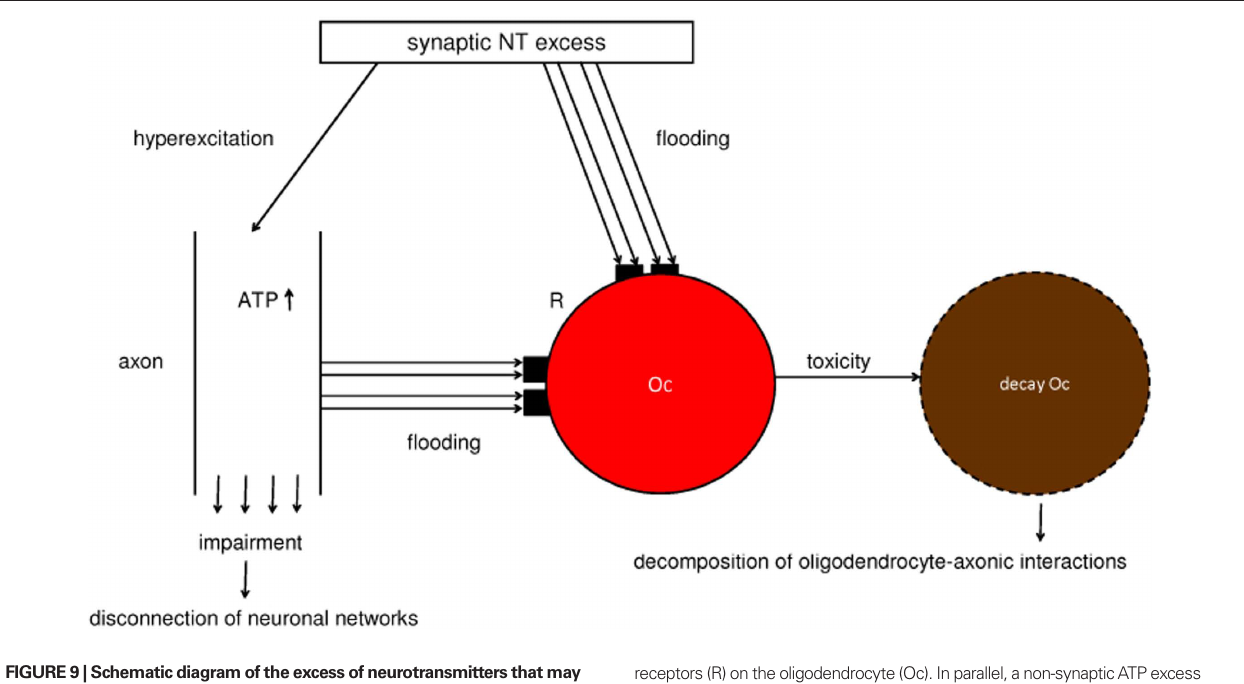
receptors (R) on the oligodendrocyte (Oc). In parallel, a non-synaptic ATP excess occurs, also flooding R. This flooding of NT and ATP exerts a toxic effect on the Oc, leading to its decay. These mechanisms may be responsible for the decomposition of oligodendrocyte–axonic interactions and the disconnection of neuronal